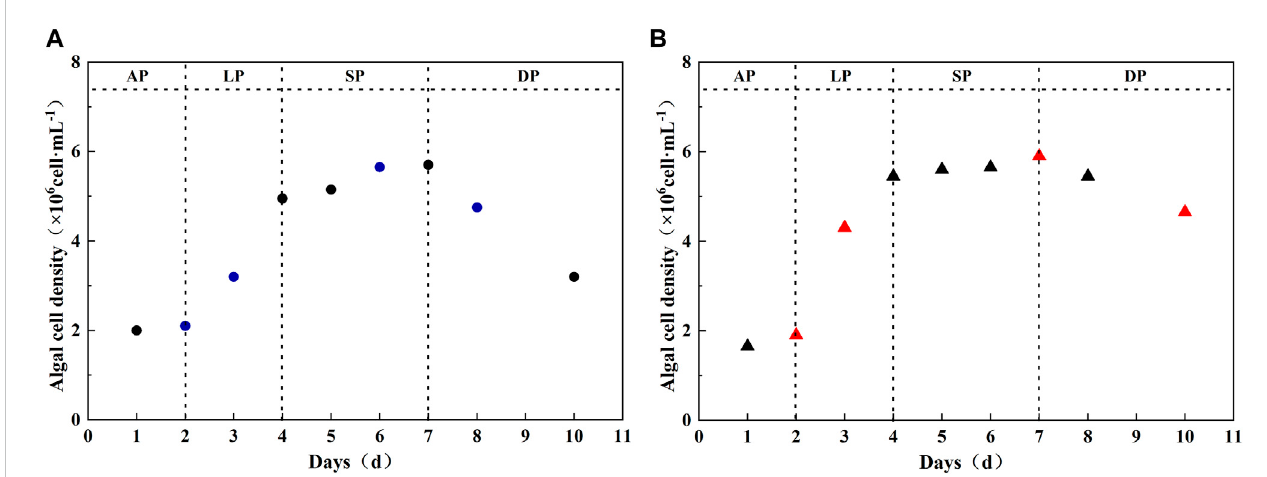
FIGURE 1 Growth curves of Chlorella vulgaris and Scenedesmus obliquus (colored points represent the characteristic days of each growth period). (A) Chlorella vulgaris ; (B) Scenedesmus obliquus . AP, adaptation phase; LP, logarithmic phase; SP, stationary phase; DP, decline